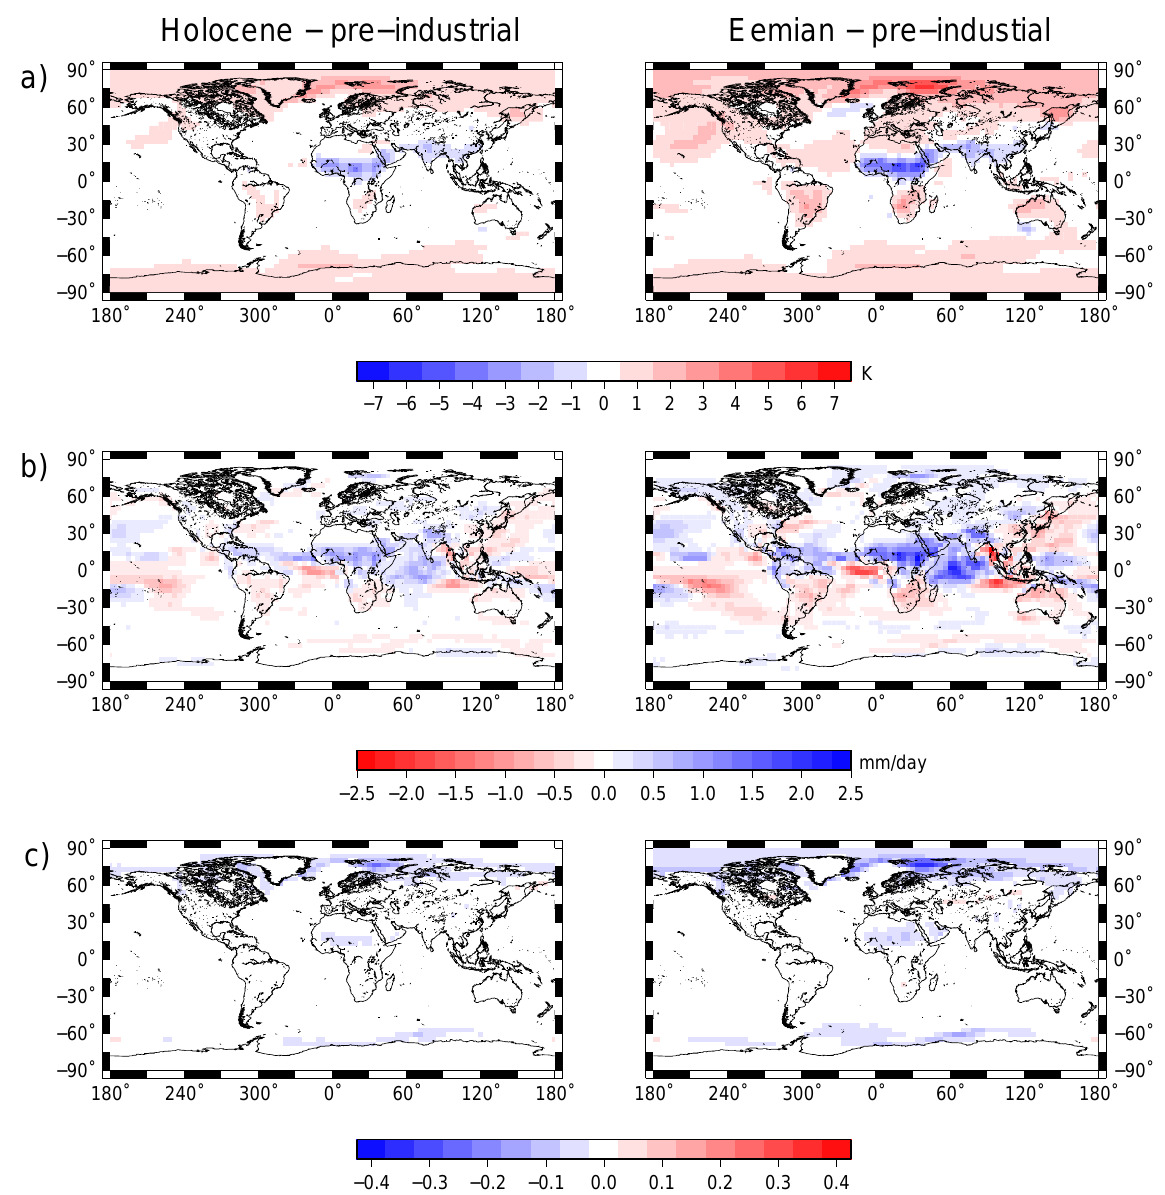
Fig. 1. 1000 year mean differences of Holocene (left) and Eemian (right) minus pre-industrial: (a) near surface temperature (2m-temperature) in K, (b) precipitation in mm/day (c) surface